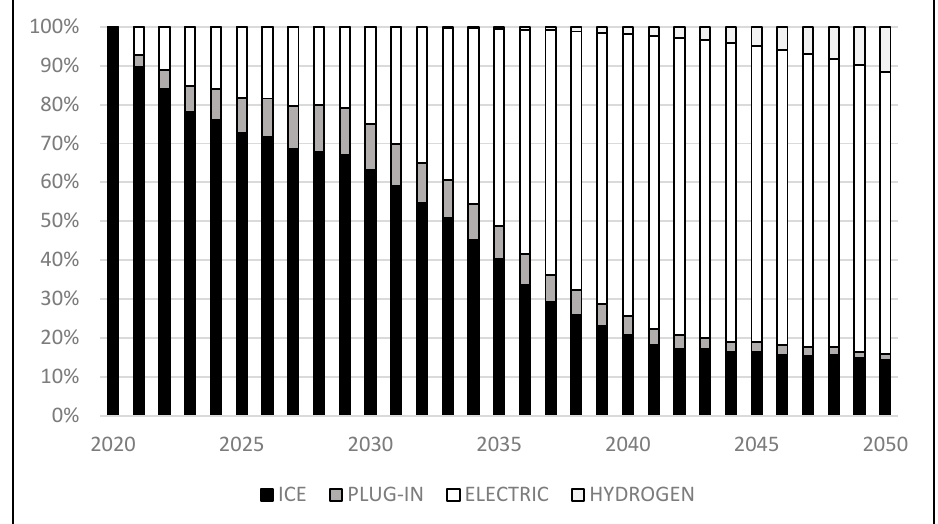
Figure 15. New passenger cars fleet in Poland [NEU scenario]. Source: own calculations based on TR 3 E model results.